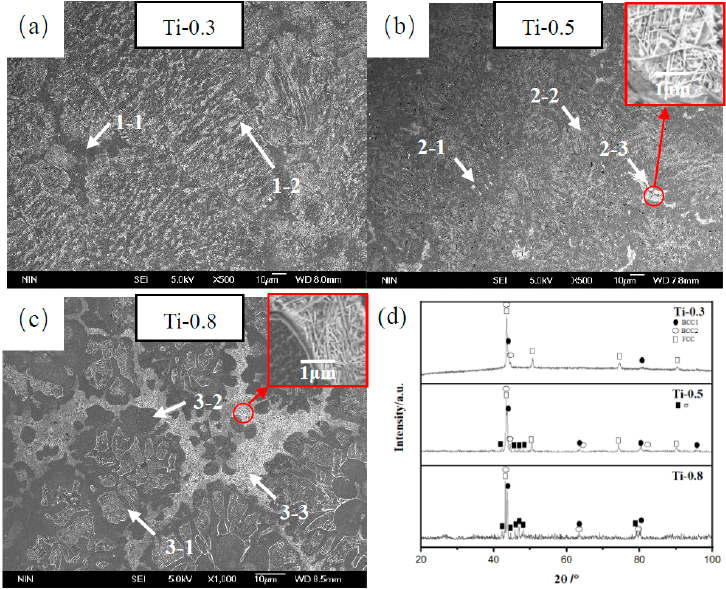
Figure 1. Microstructure and XRD results for Al0.5CoCrFeNiTi x HEAs: ( a ) Ti-0.3 alloy, ( b ) Ti-0.5 alloy, ( c ) Ti-0.8 alloy, and ( d ) XRD results.